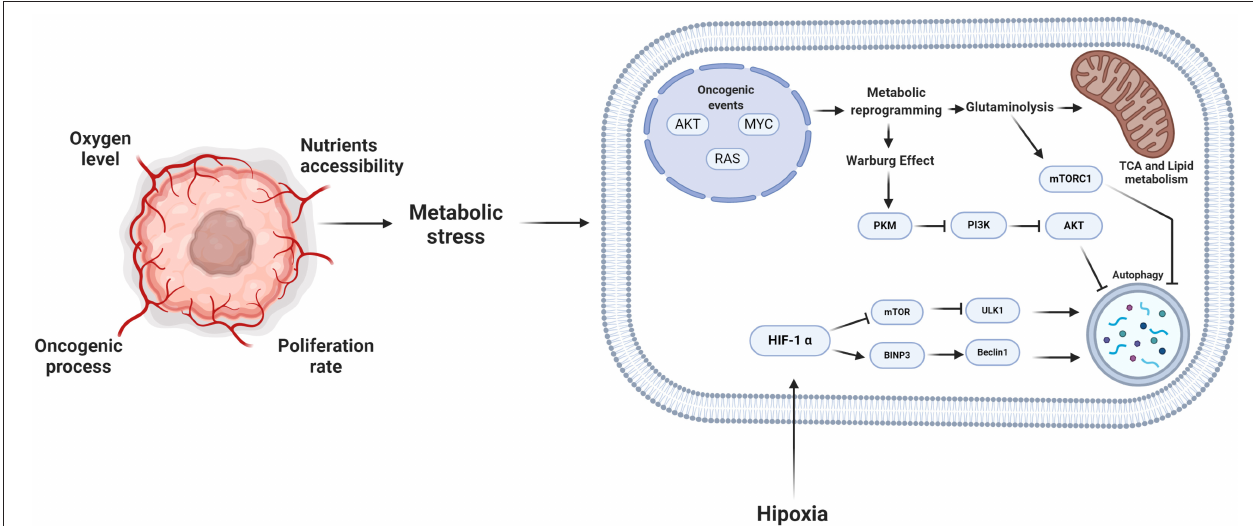
FIGURE 3 | Metabolic stress and autophagy. During the oncogenic process, the proliferation rate and the microenvironmental conditions promote that the tumor cells reprogram their metabolism. Consequently, autophagy plays an essential role in this reprogramming, providing different substrates to feed the pathways of tumor cells. However, the induction of autophagy depends on the stimuli to which the cell is subjected, the alteration of oncogenes such as MYC or RAS, the autophagy process is inhibited and during some microenvironmental tumor conditions such as hypoxia, autophagy is promoted. Created by BioRender.com.